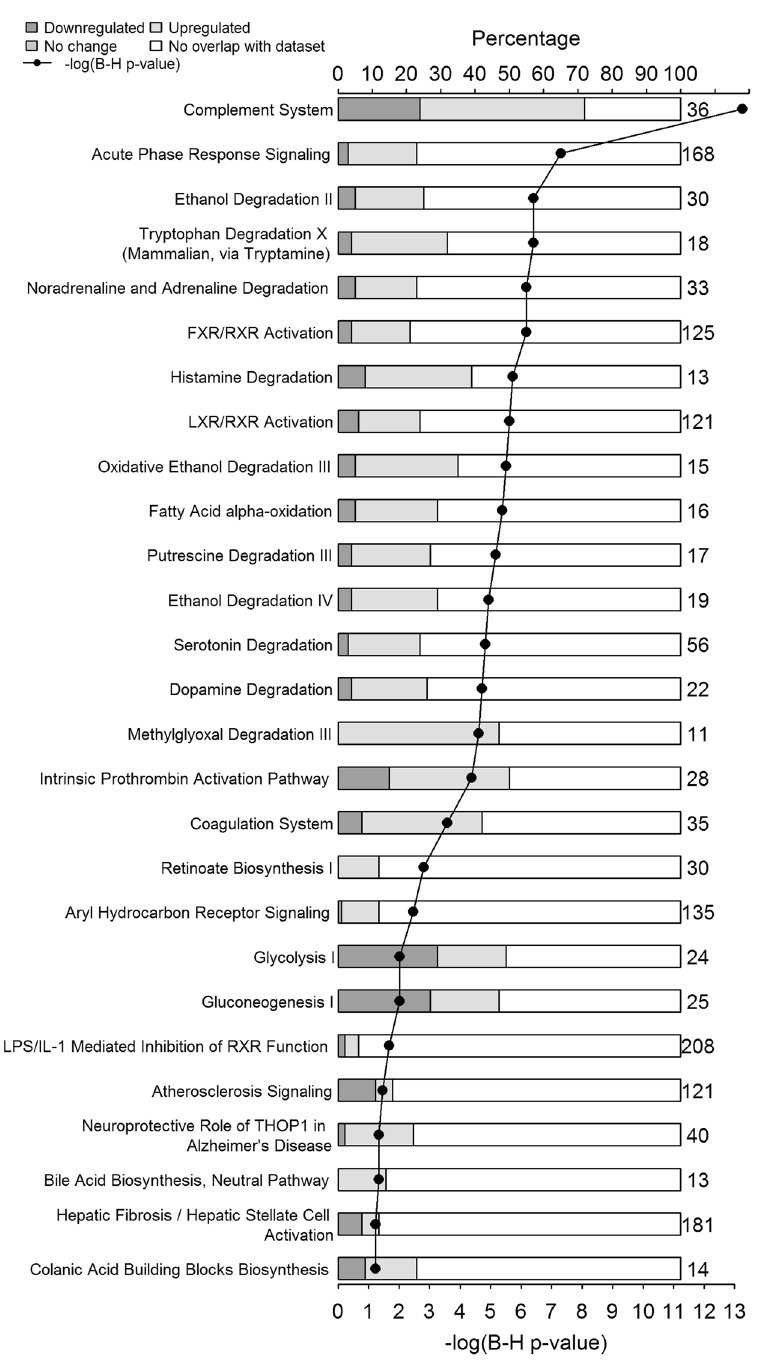
Figure 1. Canonical Pathways represented by proteins differentially expressed between ARDS survivors and non-survivors . Ingenuity Pathway Analysis (IPA) canonical pathways most significantly changed in ARDS survivors compared to non-survivors. The stacked bar chart displays the percentage of proteins in the canonical pathway that are more (light gray), less (dark gray) abundant in survivors or absent (white) our dataset. The secondary x-axis shows the − log of Benajmni-Hochberg corrected p-value indicating the statistical significance of each over-represented pathway (cutoff > 1.3) and the line with solid diamonds is the − log of corrected p-value for that pathway. The numerical value on right side of each stacked bar is the number of genes in that canonical pathway in the IPA